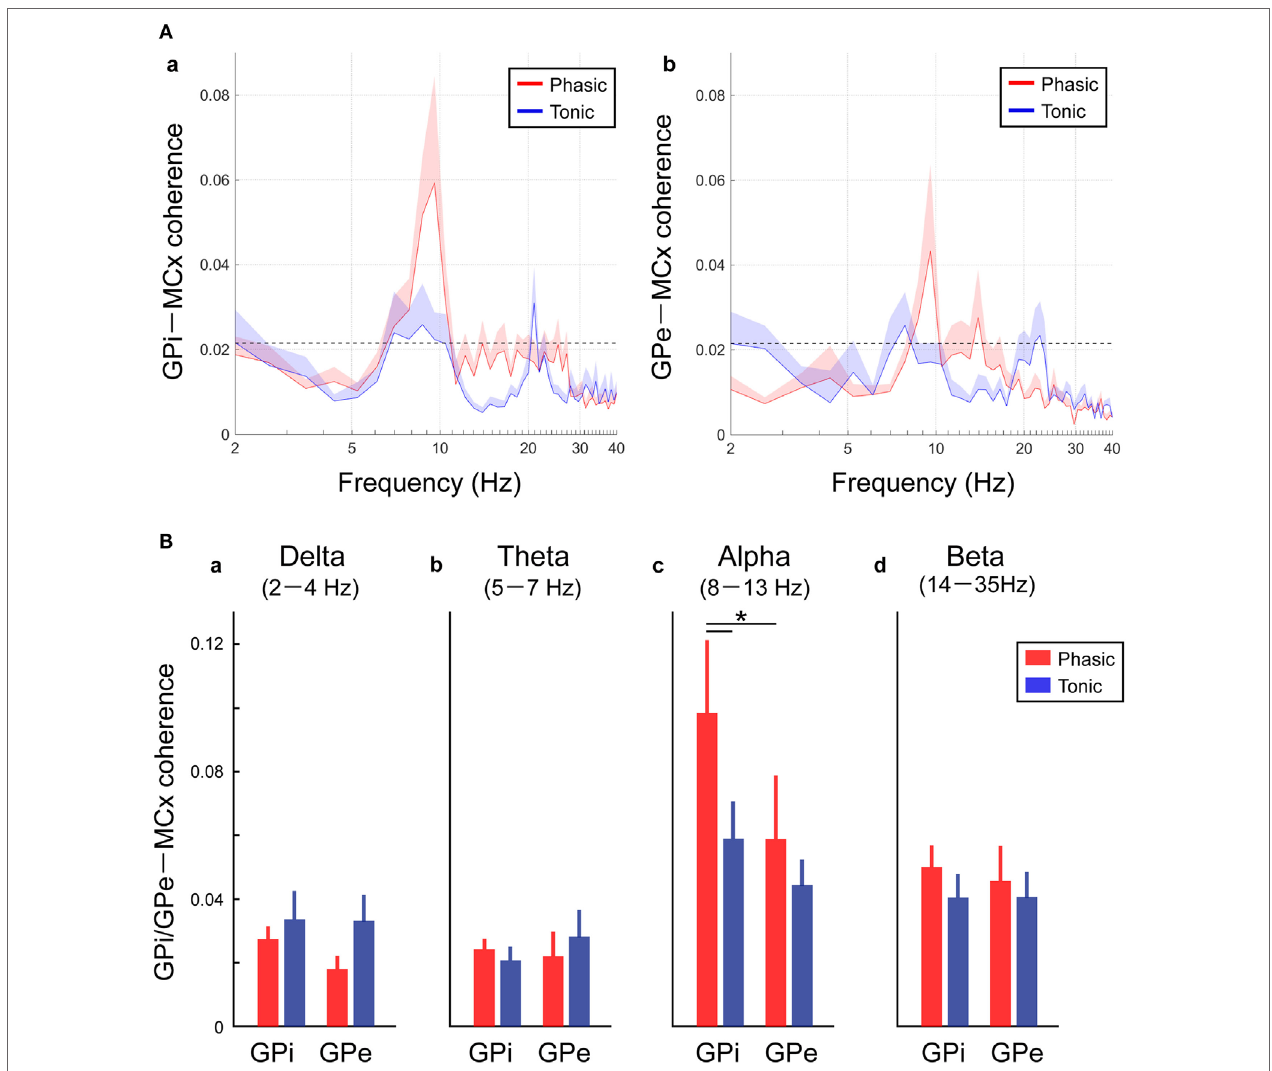
FigUre 4 | Resting-state GPi-MCX and GPe-MCx coherences in the phasic and tonic patients. (a) Red and blue lines represent the averaged GPi-MCx coherence (a) and GPe-MCx coherence (b) in phasic and tonic patients, respectively. The shaded areas represent the SE. The black horizontal dotted lines show the significant level of coherence. The peaks of the significant GPi-MCx and GPe-MCx coherences are found in the alpha range, especially in phasic patients. (B) Red and blue bars represent the averaged value of GPi-MCx and GPe-MCx coherences over the delta (2–4 Hz) (a), theta (5–7 Hz) (b), alpha (8–13 Hz) (c), and beta (14–35 Hz) (d) bands in phasic and tonic patients, respectively. The alpha GPi–MCx coherences are higher in phasic than in tonic patients (* p <